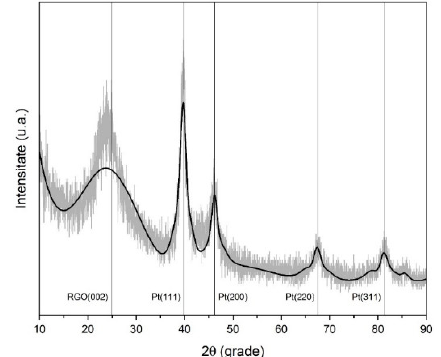
Table 4. XRD peak parameters.